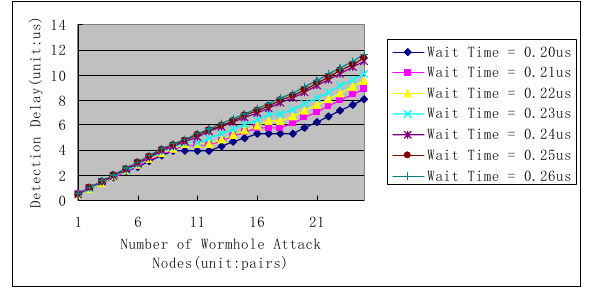
Fig.9. Detection Delay for Different Wait Times